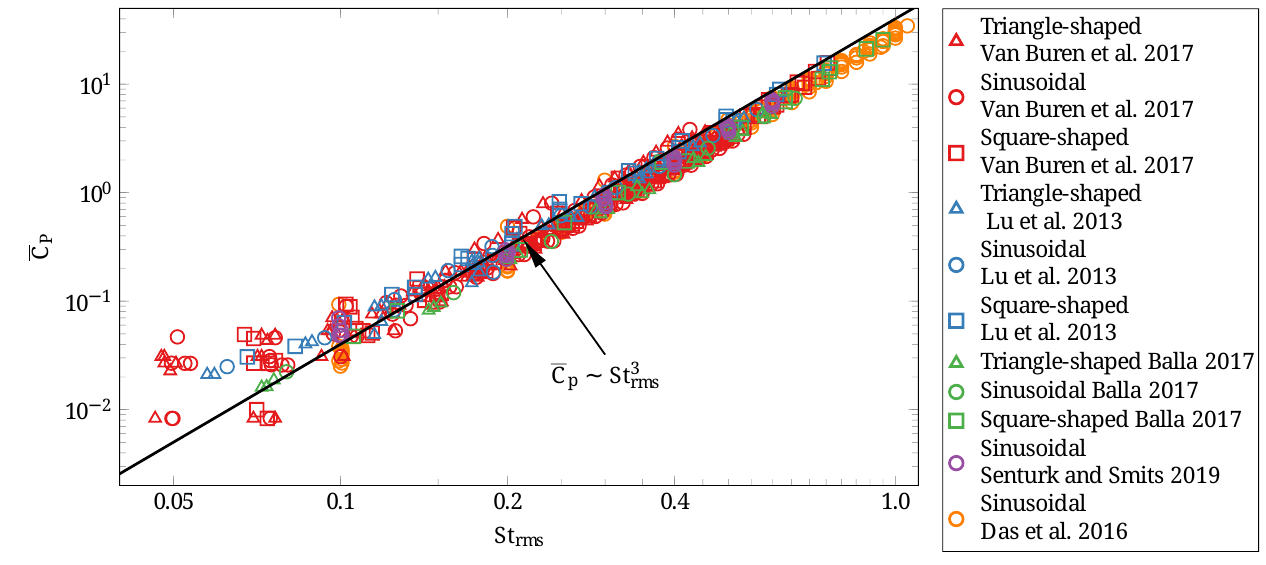
Figure 3. Mean power coefficient C p as a function of the root mean square Strouhal number St rms for periodically pitched foils. The symbols used to distinguish between different cases are exactly the same as in Figure 2. The solid line represents a cubic power law fit through the discrete data